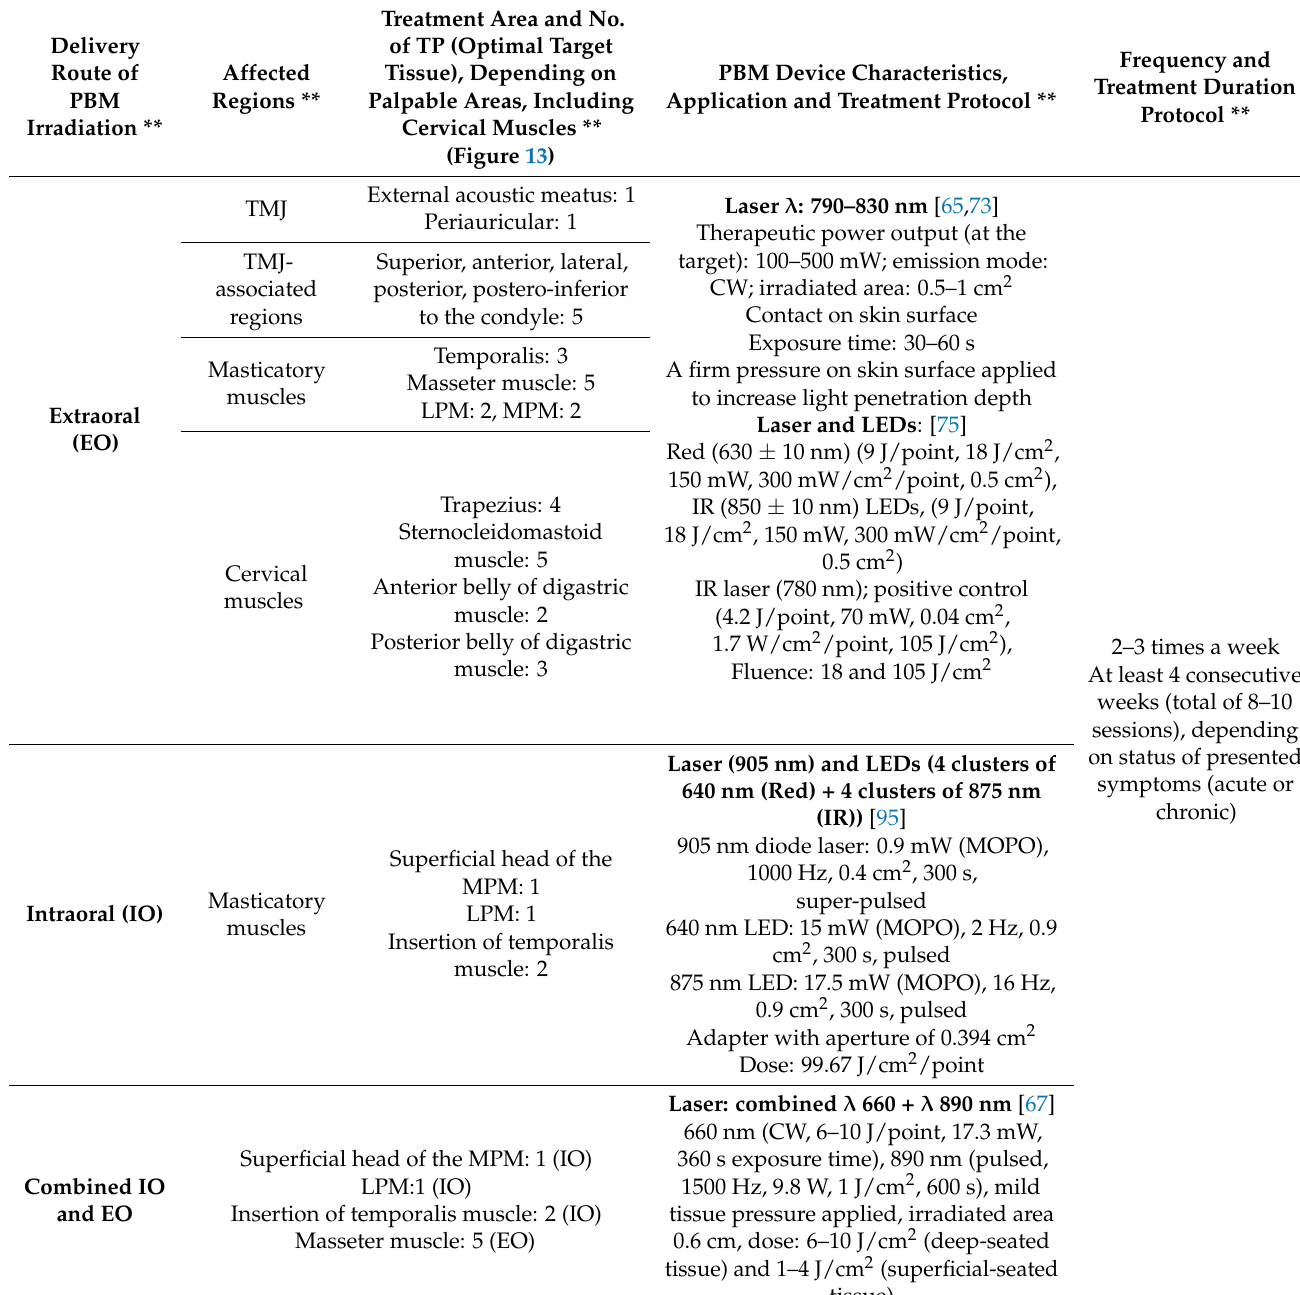
Table 3. Illustrates PBMT protocols for chronic TMD symptoms of deep-seated tissue injurie derived from the literature and evidence-based clinical practice (studies utilised power meter) and expert opinion. These protocols are intended only to provide clinical guidance and to serve as a starting point for extensive research. ** All the abbreviations in this table are listed in Supplementary File S2.